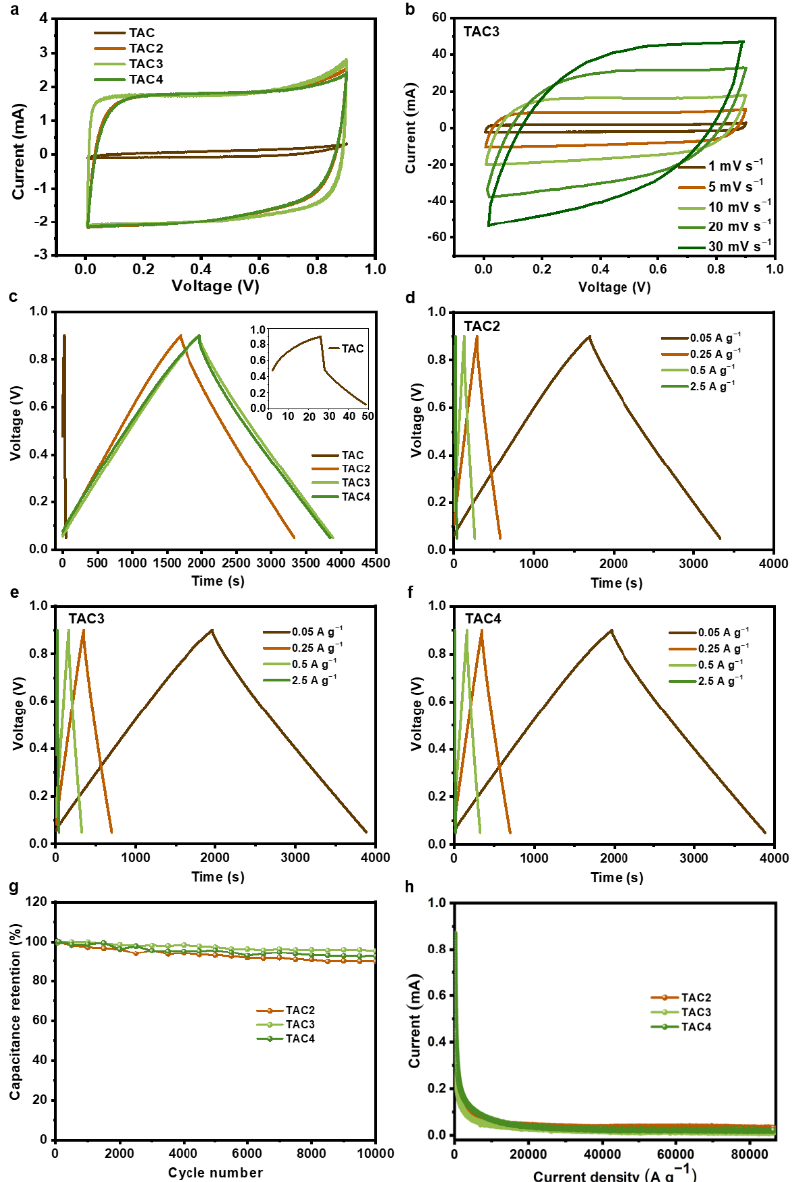
Figure 4. CV curves of the as-prepared samples at the scan rate of 1 mV s − 1 ( a ); CV curves of TAC3 at different scan rates ( b ); GCD curves of all the samples at 0.05 A g − 1 ( c ); GCD curves of TAC2 ( d ), TAC3 ( e ), and TAC4 ( f ) at different current densities; cycling performance under 1000 cycles of tea-waste-based activated carbons ( g ); and the leakage current curves of tea-waste-based activated carbons ( h ).